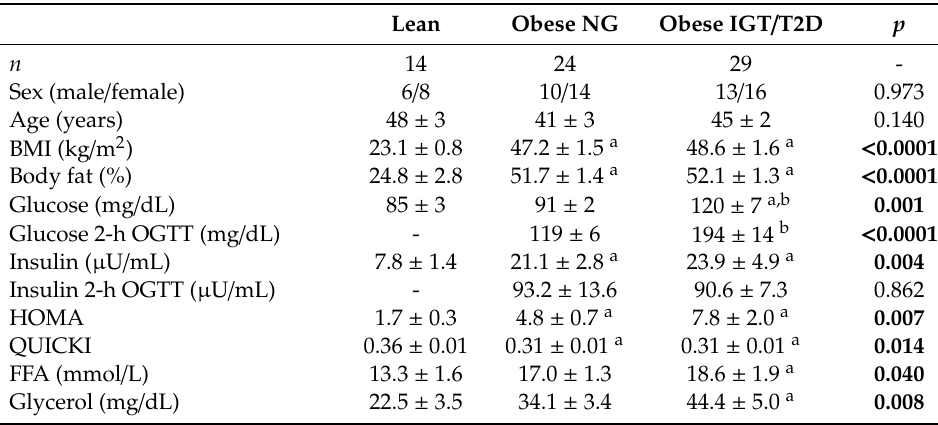
Table 1. Clinical characteristics of the subjects of the